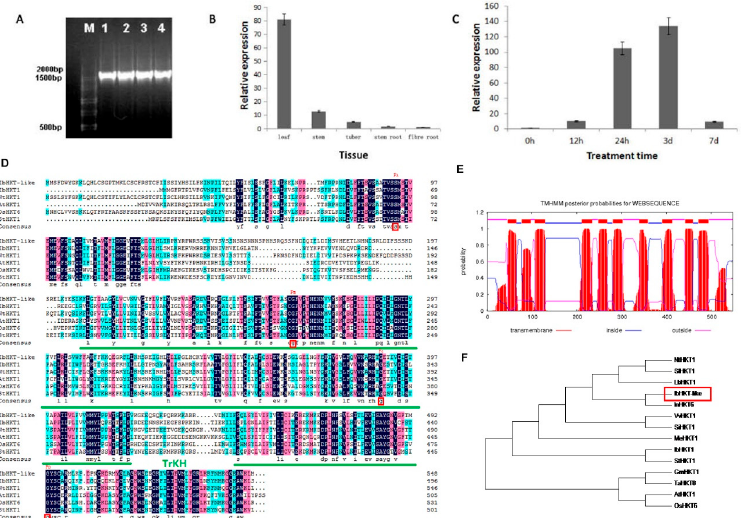
Figure 1. Identification of IbHKT-like gene and phylogenetic analysis. ( A ) Evaluation of amplified IbHKT-like gene sequence. ( B ) Expression pattern of IbHKT-like gene in different tissues of sweet potato. ( C ) Expression pattern of IbHKT-like gene in NZ 1 under low potassium stress. ( D ) Multiple sequence alignment and conserved domain analysis of IbHKT-like protein. ( E ) Prediction of the transmembrane domain of IbHKT-like protein, green lines are conservative domains, and red boxes are conservative sites. ( F ) Phylogenetic tree of HKT transporter with maximum-likelihood method. The ordinate is the relative expression level of the IbHKT-like gene. IbARF was used as the internal reference for data processing. Values indicated the mean and standard deviation of biological repetitions ( n = 3).